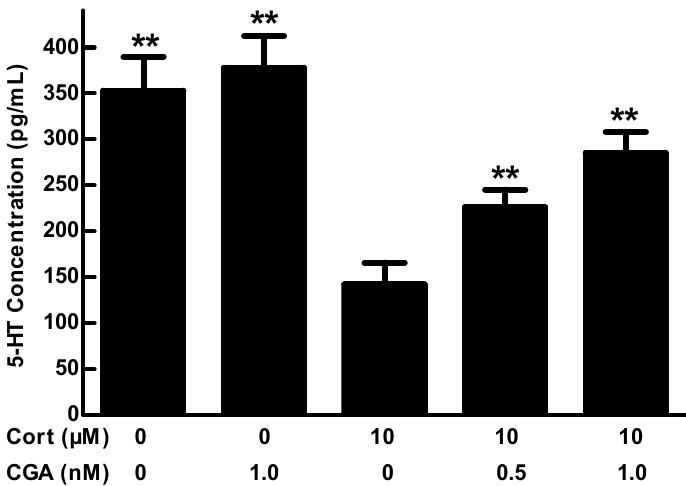
Figure 2. The effects of CGA ± Cort on 5-HT release from the cells of fetal rat raphe neurons in vitro . The results are representative of at least three independent experiments run in triplicate and expressed as the mean ± SD. ** p < 0.01 vs. Cort-treated group. The control cells were treated with culture medium with 0.1% DMSO.